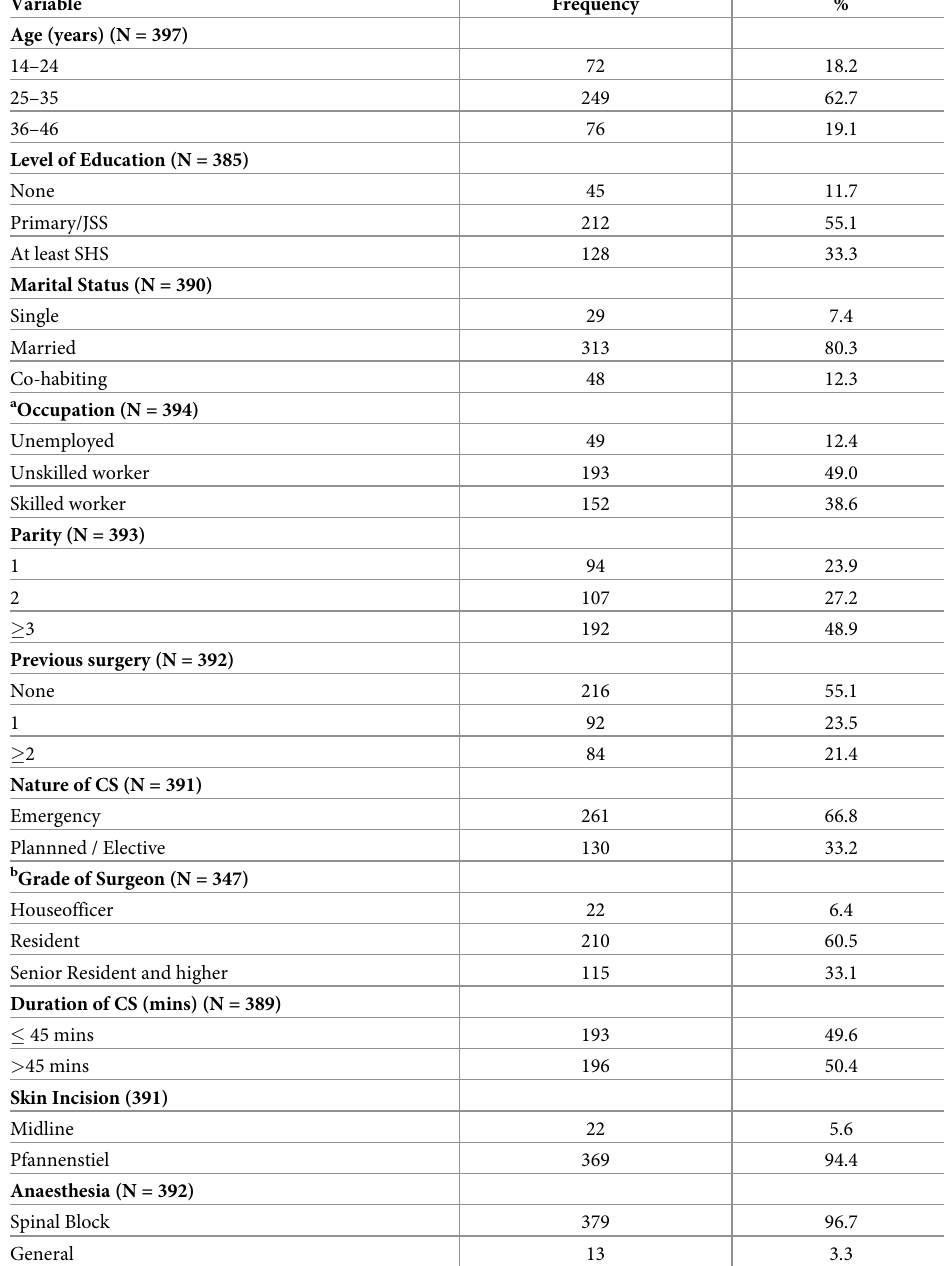
Table 1. Demographic and surgical characteristics of the study